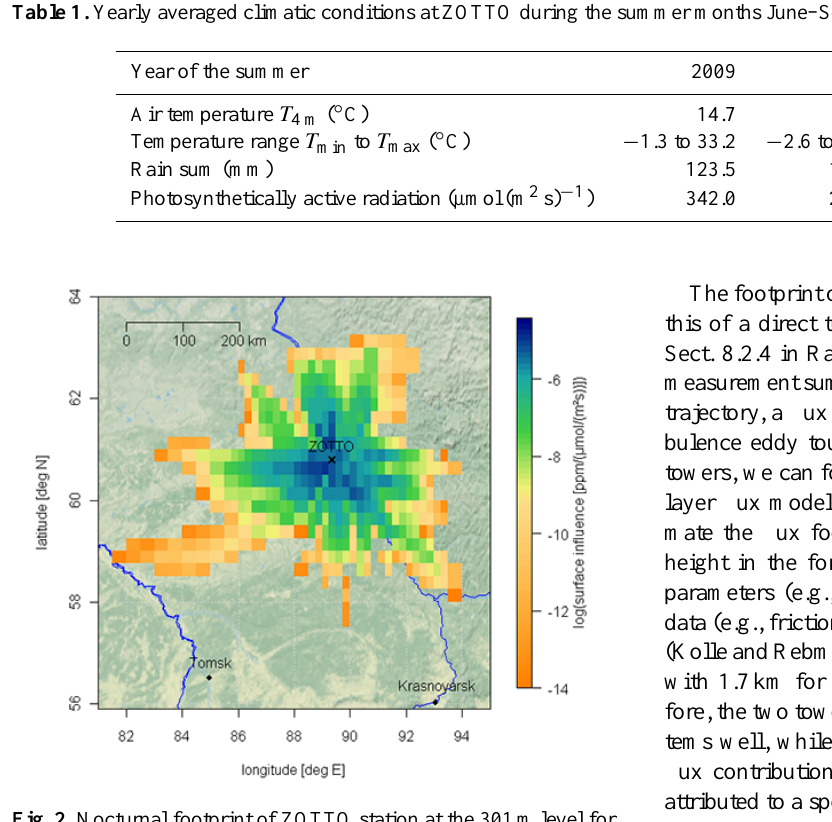
Fig. 2. Nocturnal footprint of ZOTTO station at the 301m level for months June to September 2009 (based on back trajectories from 05:00 back to 23:00 the previous evening with the STILT